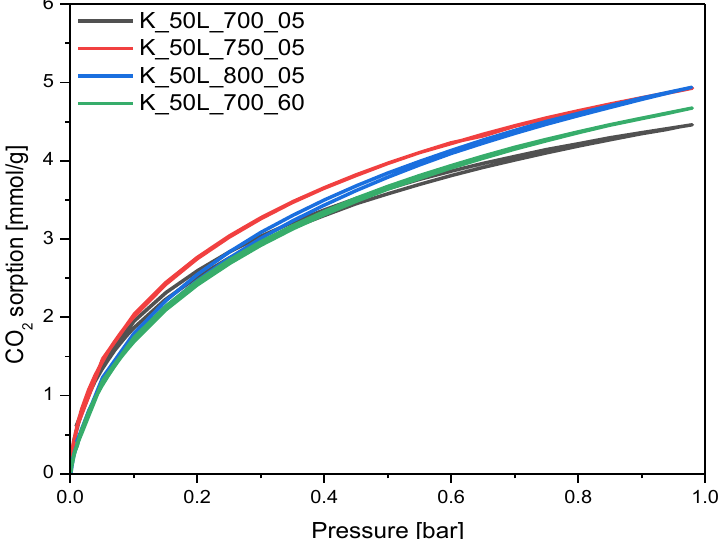
Figure 13. CO 2 sorption isotherms at 0 °C of the samples activated at different temperatures and with different dwell times.